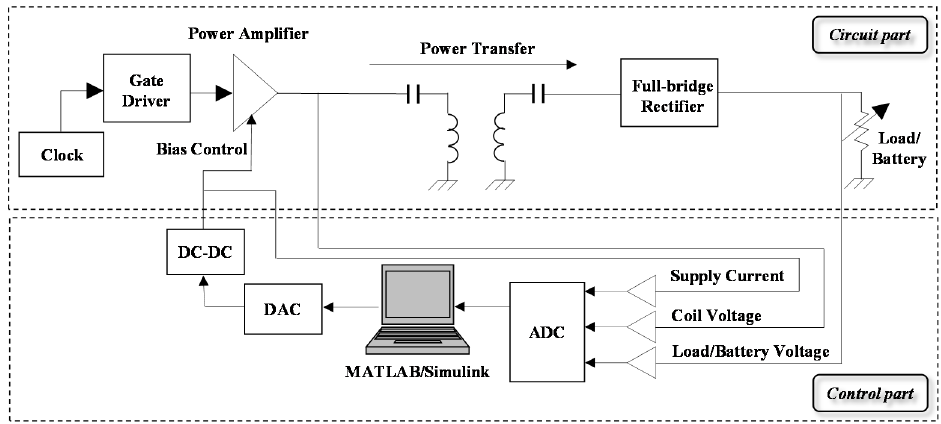
Figure 1. Overall block diagram of software-based wireless power transfer platform for power control